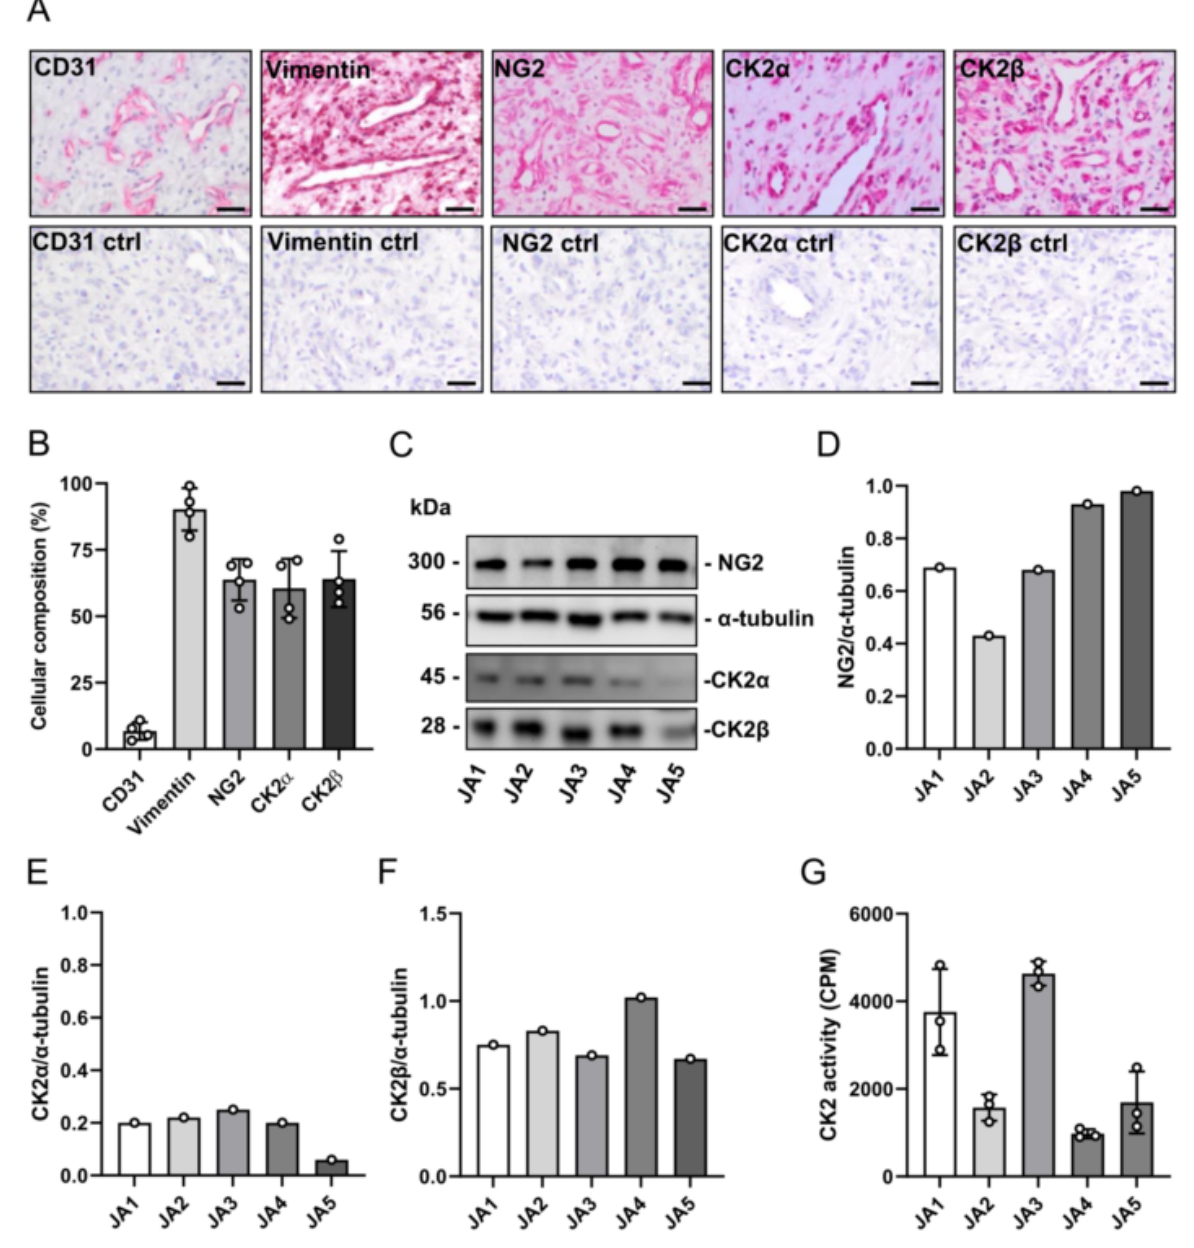
Figure 1. Expression of CK2 and NG2 in the patient-derived JA tissue samples. ( A ) Representative immunohistochemical stainings of CD31, vimentin, NG2, CK2 α and CK2 β from JA1 (upper panel). Scale bars: 25 µ m. Immunohistochemical staining without primary antibodies served as a negative control (ctrl, lower panel). Scale bars: 25 µ m. ( B ) Quantitative analysis of ( A ). The number of CD31-, vimentin-, NG2-, CK2 α - and CK2 β -positive cells is given as % of all the cells per section. Mean ± SEM ( n = 4). ( C ) JA tissue samples from 5 patients (JA1–JA5) were lysed and the expression of NG2, CK2 α , CK2 β and α -tubulin (as a loading control) was analyzed by Western blot. ( D – F ) Quantitative analysis of ( C ). Data are expressed as the relative density ratio of NG2/ α -tubulin ( D ), CK2 α / α -tubulin ( E ) and CK2 β / α -tubulin. ( G ) CK2 kinase activity (CPM) was measured by a CK2 kinase assay. Mean ± SD ( n = 3).